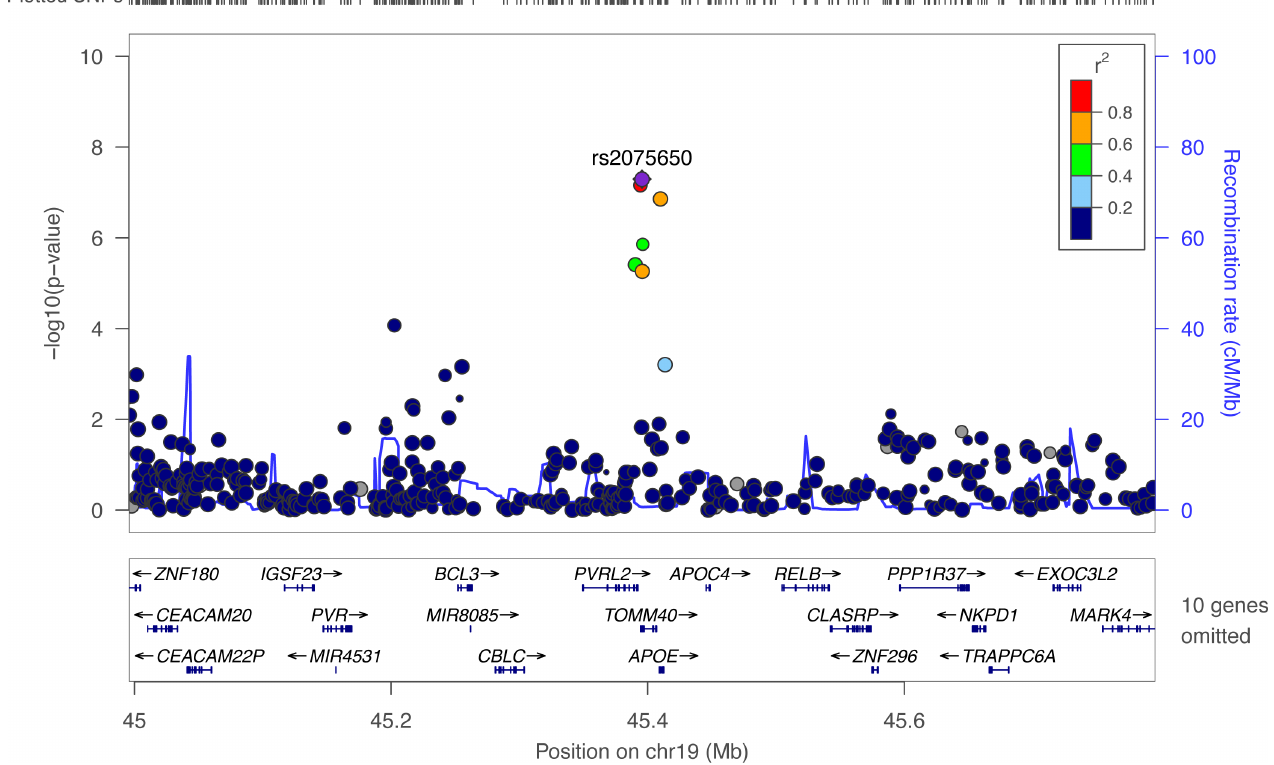
Fig 3. Regional plot showing the results for the association between rDR-L in HRS, with the top SNP in TOMM40 (rs2075650) identified. The y-axis shows -log 10 P-values; x-axis shows position of genes on chromosome 19. The diamond(purple)represents the top genome-wide significantSNP. The circles represent each genotyped SNP in the region400-kb in both directions from rs2075650; the circle color indicates pairwiselinkagedisequilibrium (LD) in relationto the top SNP (calculated from hg19/1000Genomes Nov 2014 EUR). The solid (blue) line indicates the recombination rate.